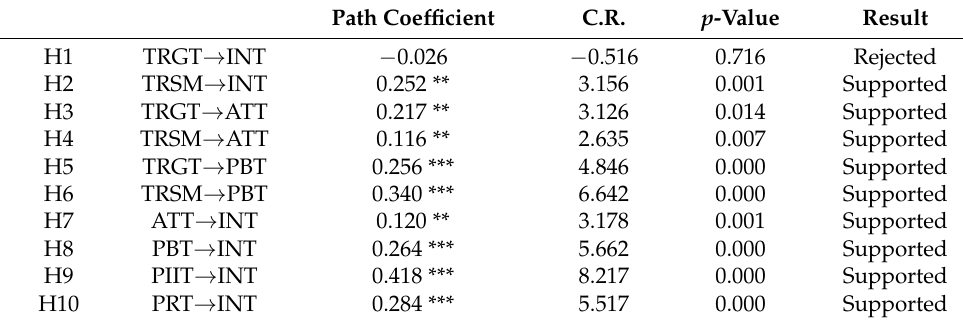
Table 3. Path coefficients of structural equation model.